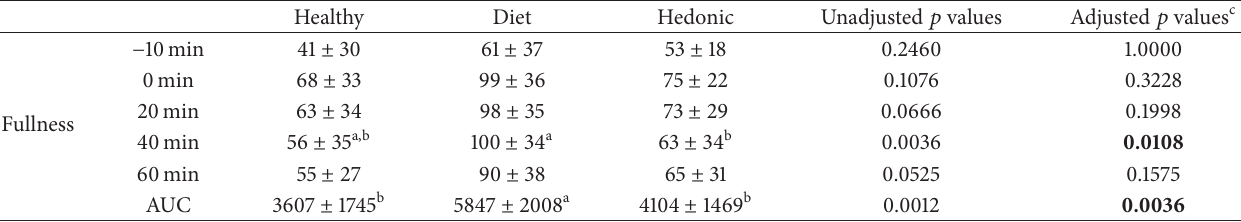
Table 6: Fullness in overweight/obese unrestrained men for each experimental condition. Healthy Diet Hedonic Adjusted 𝑝 values